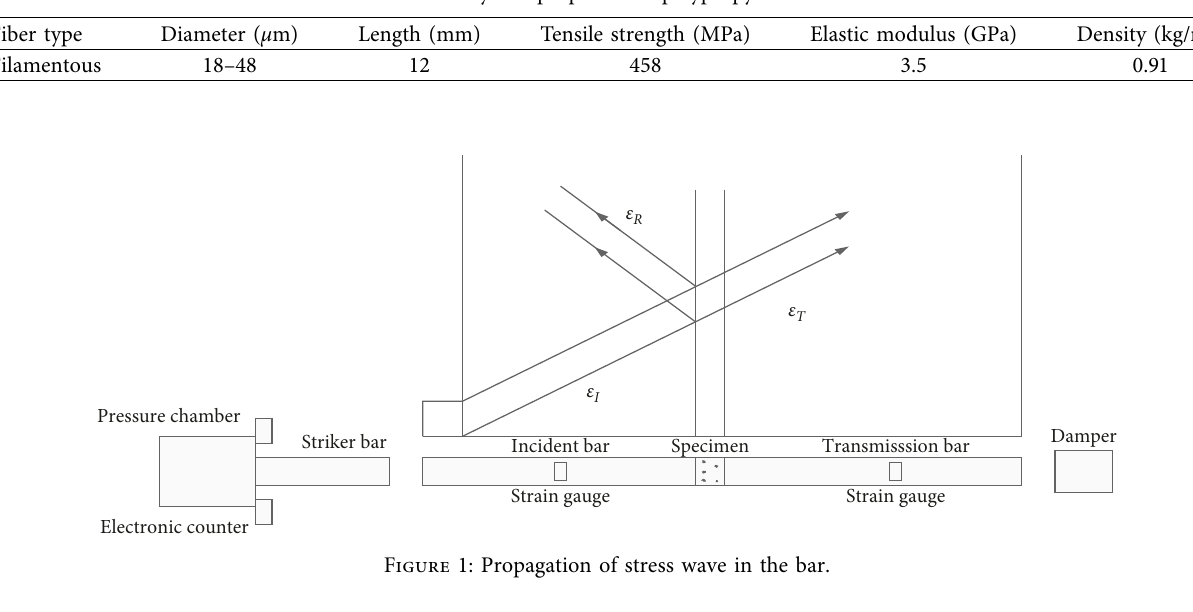
Table 2: Physical properties of polypropylene